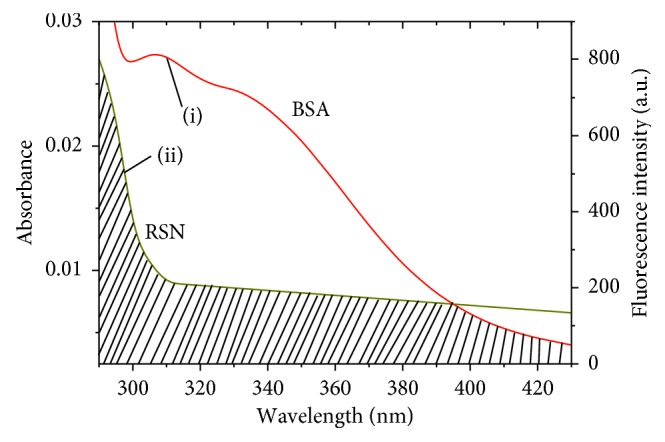
Overlap spectrum between (i) the fluorescence emission spectrum of BSA and (ii) the UV absorption spectrum of RSN. The concentration of BSA and RSN is 3.0 × 10−6mol · L−1 at 297 K and pH 7.40.